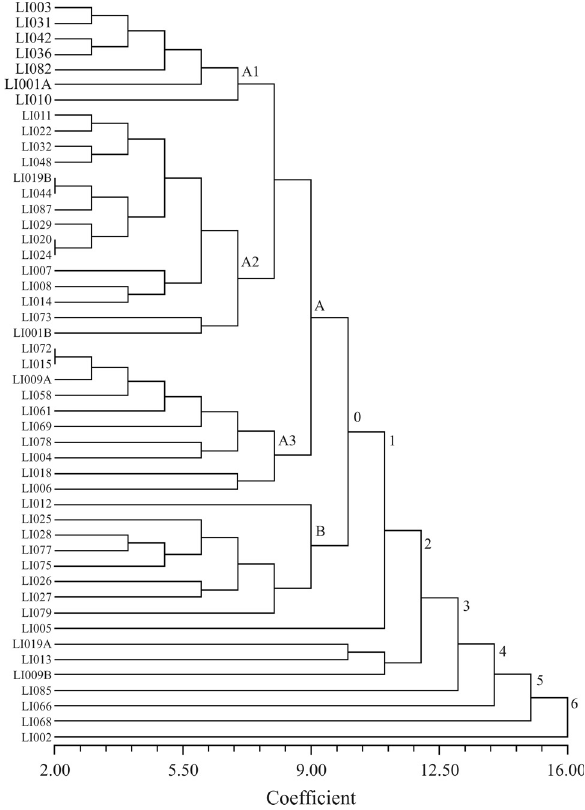
Figure 2 - Dendrogram showing phenetic relationship of 48 lines of Kerria, generated from Jaccard’s similarity coefficients, based on RAPD data, and using the neighbour-joining